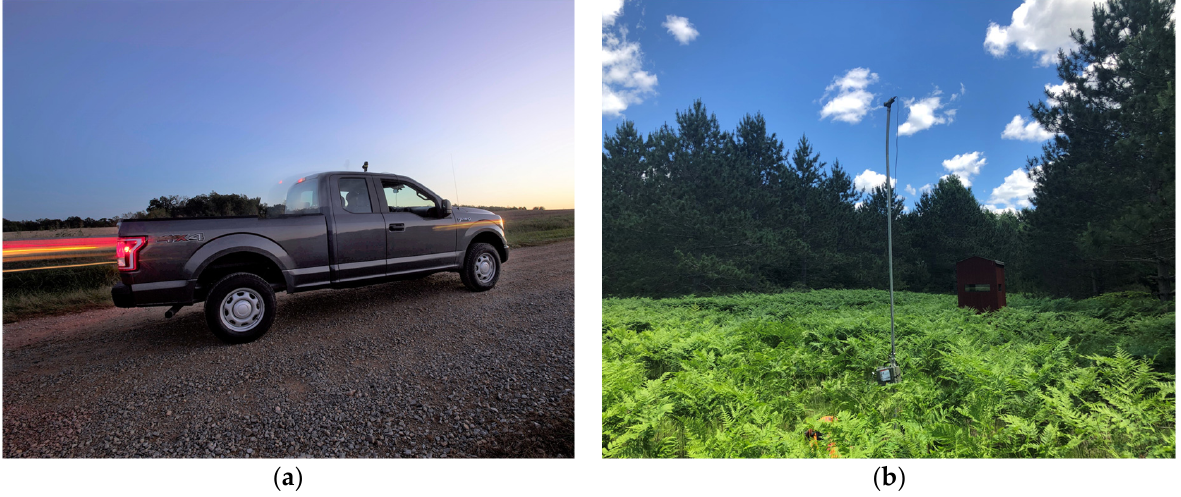
Figure 2. Image of a mobile acoustic transect ( a ) being conducted in North Carolina, United States., reproduced with permission from Melissa McGaw, North Carolina Wildlife Resource Commission. There are currently more than 1.142 million mobile acoustic records in the NABat database [25]. Image of a stationary acoustic deployment ( b ) in Northern Michigan, United States, reproduced with permission from Crystall Birdsall. There are currently more than 62.285 million stationary acoustic records in the NABat database [25].